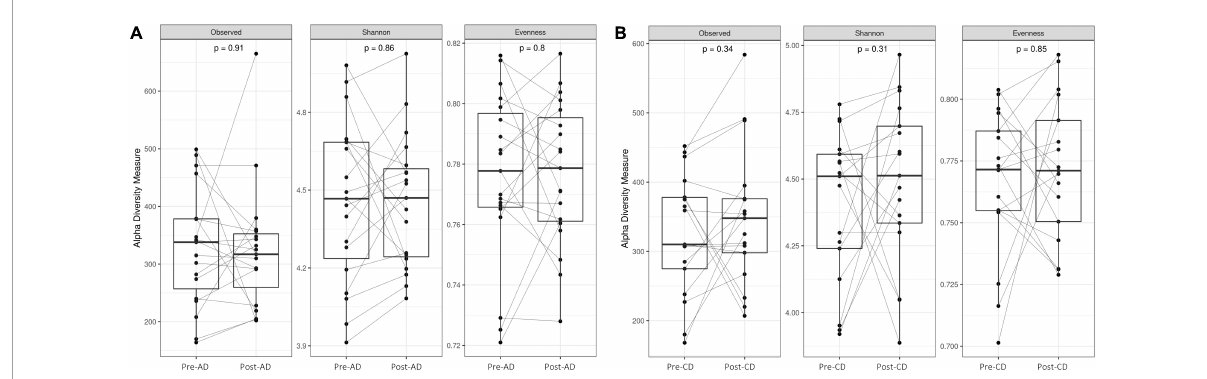
FIGURE2 Box plots reporting alpha diversity indices (Observed ASV richness, Shannon index, Pielou’s evenness) pre- and post-AD (A) and pre- and post-CD (B) . Lines link paired samples and statistical differences were assessed using the Wilcoxon signed-rank test. p -values less than 0.05 were considered statistically significant. AD, ancient-wheat diet; CD, control-wheat diet.